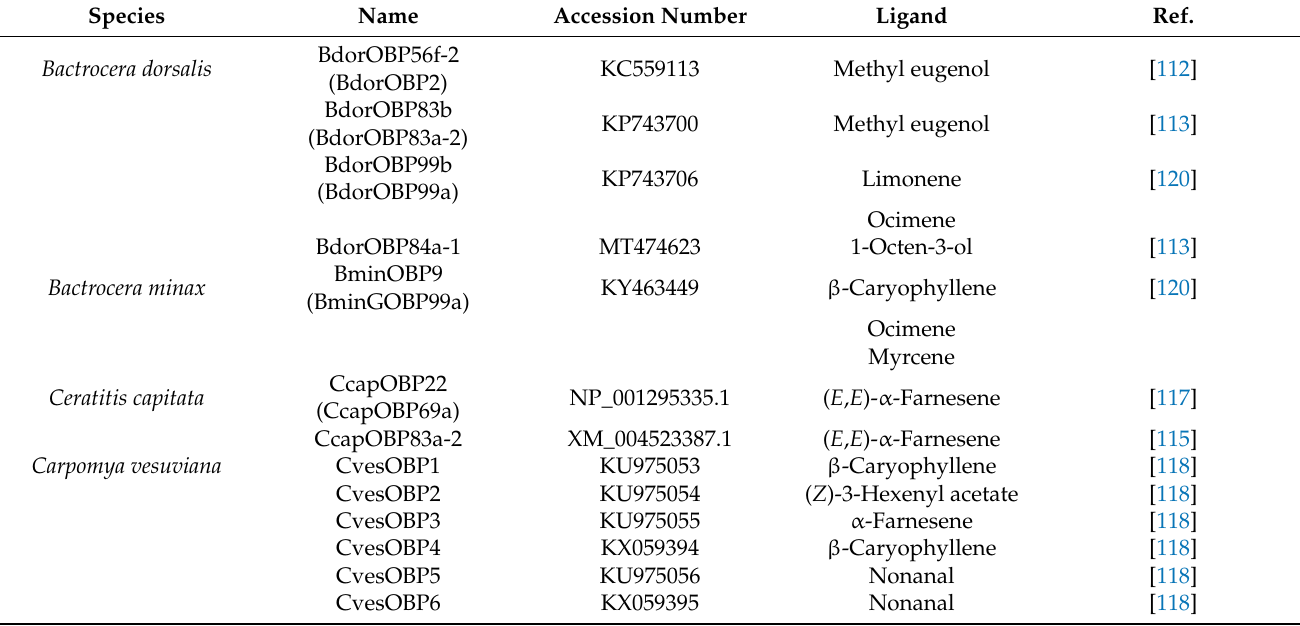
Table 1. OBPs and their high affinity